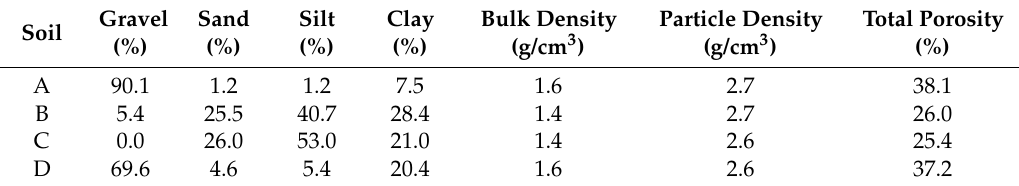
Table 2. Grain size distribution and physical properties of soils in the surroundings of Line 15. Soil